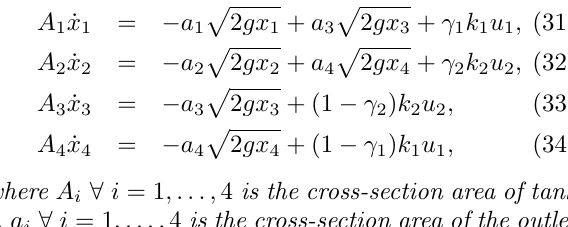
Figure 2: Simulation of the quadruple tank process and the non-minimum phase case in Example 6.1 with LQ optimal control with integral